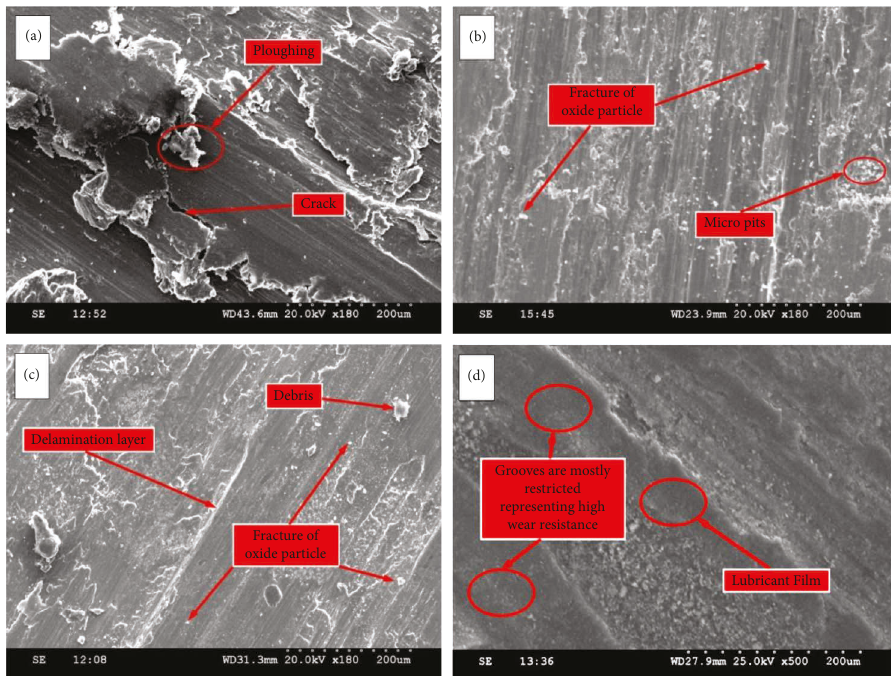
Figure 9: SEM morphologies of the worn surface of (a) AA 2024 (b) AA 2024–5 wt. % SiC (c) AA 2024–5 wt. % SiC–5 wt. % Gr (d) AA 2024–5 wt. % SiC–10 wt. % Gr composite at an applied load of 20N and a constant speed of